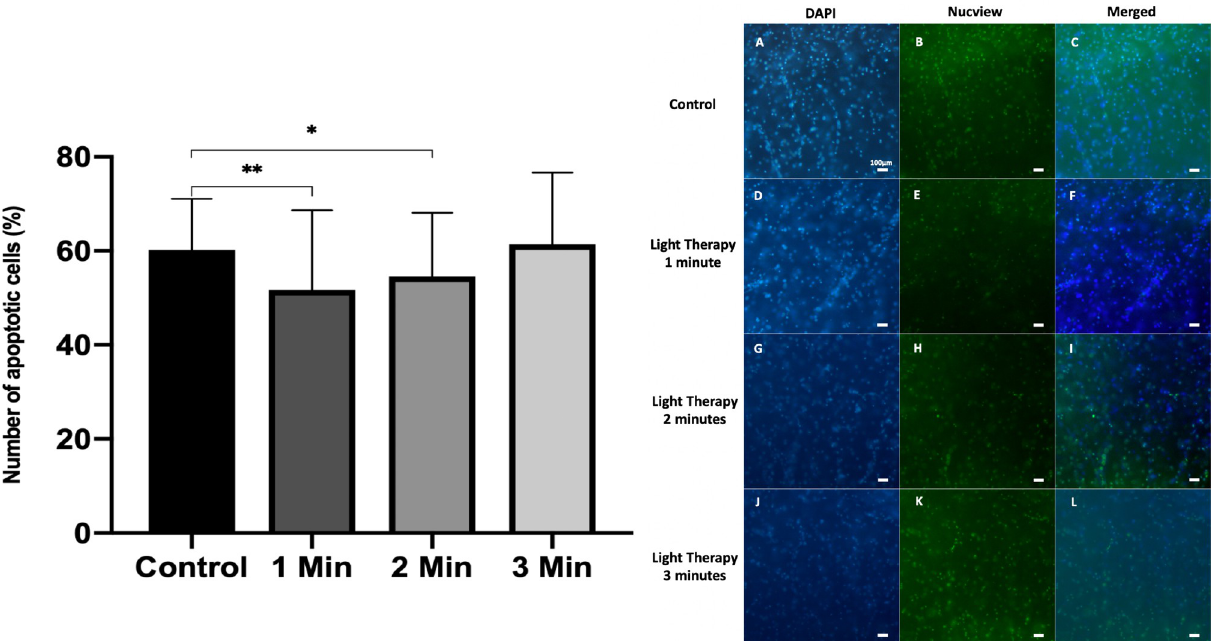
Fig 6. Percentage of apoptotic cells in response to varying light therapy durations, either 1, 2 or 3 minutes per day over 5 days. �� denotes P < 0.01, � denotes P < 0.05, error bars represent SD. DAPI = 4’, 6-diamidino-2-phenylindole.